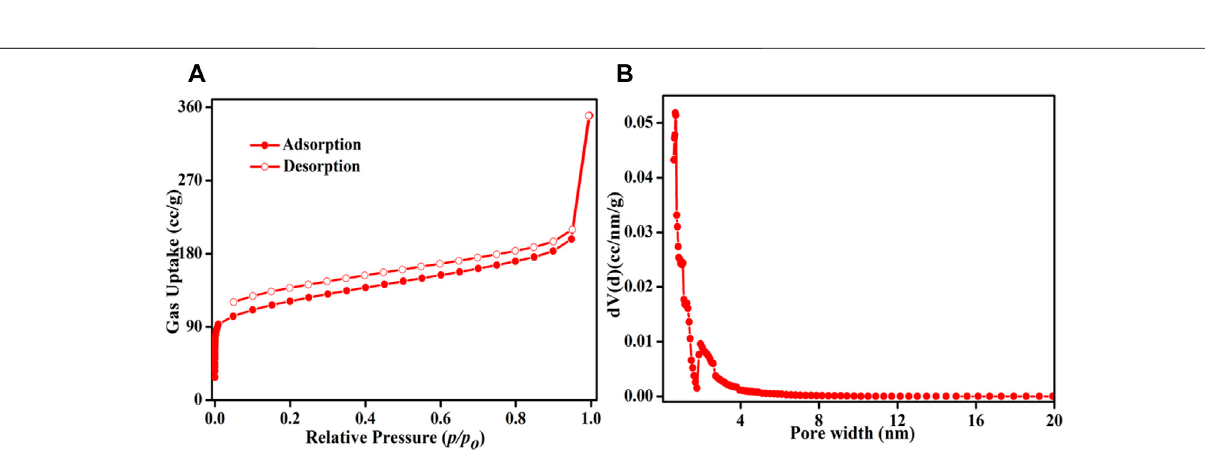
Frontiers in Chemistry |